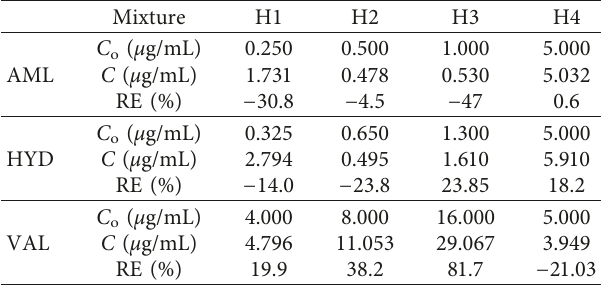
Table 2: Quantification results of AML, HYD, and VAL in a mixture using the Kalman filter with the assumption of initial guesses method (Solution 1).